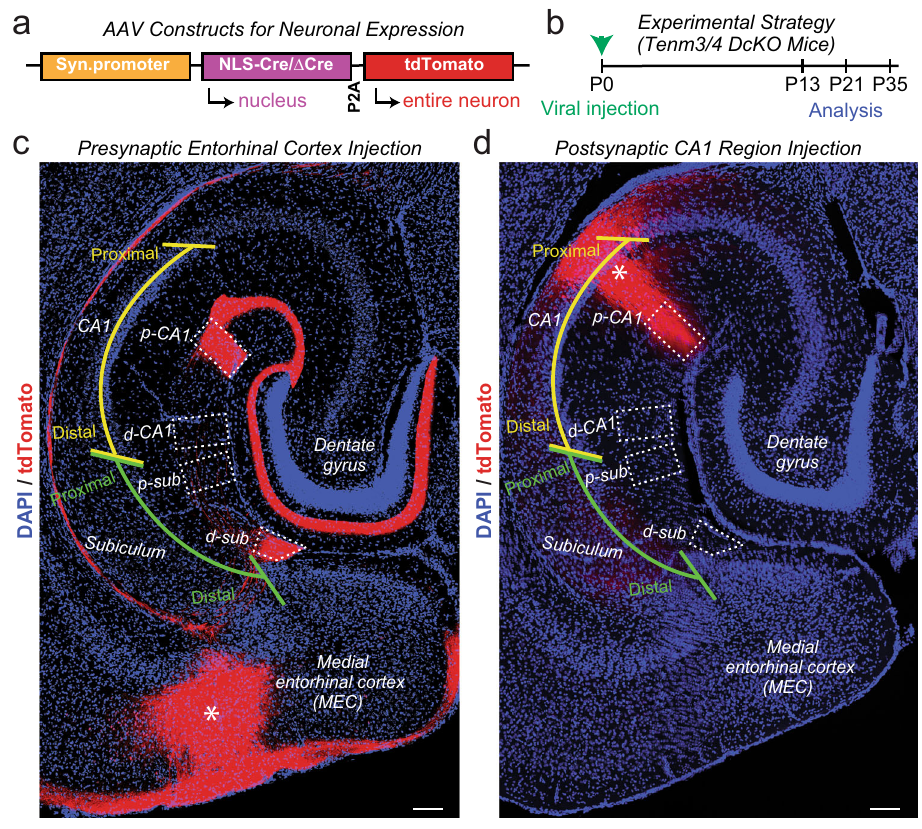
Fig. 4 Strategy for selective deletions of both Tenm3 and Tenm4 from the MEC or CA1 in Tenm3/4 double cKO mice to achieve exclusively pre- or postsynaptic ablation of Tenm3 and Tenm4 expression. a Design of AAVs used for Tenm3/4 deletions. The synapsin promoter drives bicistronic expression of Cre or Δ Cre (control) and soluble tdTomato, enabling visualization of infected neurons and their axonal projections. b Experimental approach. Tenm3/4 DcKO mice were stereotactically infected with AAVs at P0, and analyzed at P13, P21, or P35. c Representative image of a horizontal section of the hippocampal formation of a control mouse at P13 whose MEC was infected with Δ Cre- and tdTomato-expressing AAVs at P0 (asterisk = infected area). Note that MEC neurons project abundant tdTomato-positive axons to the S. lacunosum-moleculare of the proximal CA1 (p-CA1) and the molecular layer of distal subiculum (d-sub), but not to the distal CA1 (d-CA1) or proximal subiculum (p-sub). Dotted boxes indicate areas that were quantitatively analyzed in Fig. 5a – c, Supplementary Figs. 4, 6. d Same as c , except that the CA1 region was infected stereotactically with Δ Cre- and tdTomato-expressing AAVs. Note that the CA1 region neurons, as visualized in horizontal sections, send sparse axons to distal subiculum. Dotted boxes indicate areas that were quantitatively analyzed in Fig. 5g – i, Supplementary Figs. 5, 7. Scale bars: 0.5 mm ( c , d